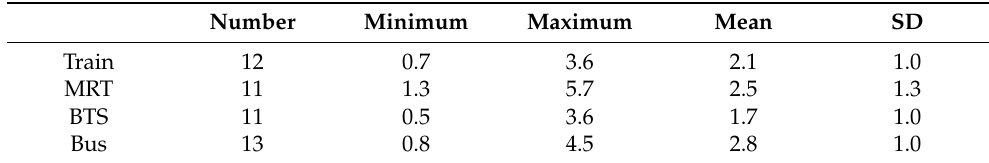
Table 2. Half-lives (in minutes) determined in the time series of PNC on four transport modes, from a total of 19 analysed time